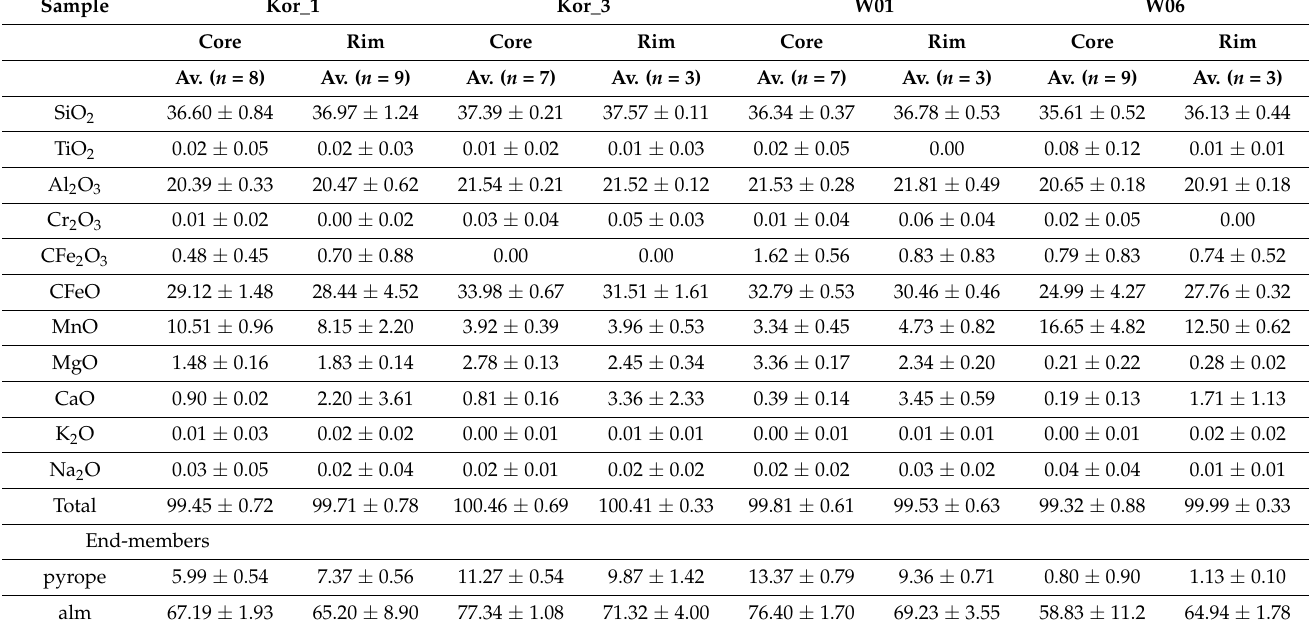
Table 1. Selected microprobe analyses of garnet core and rim areas. Average concentrations are given in wt.%. Total Fe was measured as FeO. Calculations after Spear [5]; C = calculated; n = number of selected